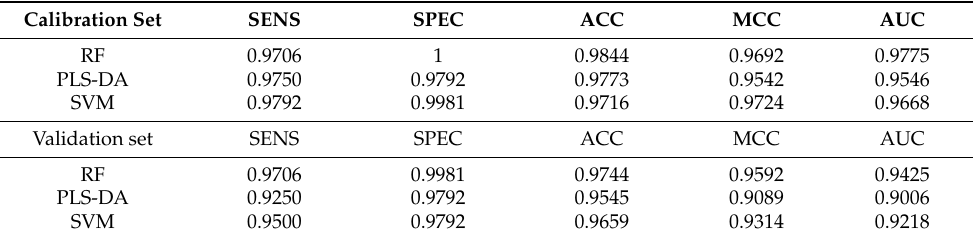
Table 3. The classification results and evaluation parameters between LJF and LF combined with RF, PLS-DA, and SVM models by vector normalization applied after the first differentiation.